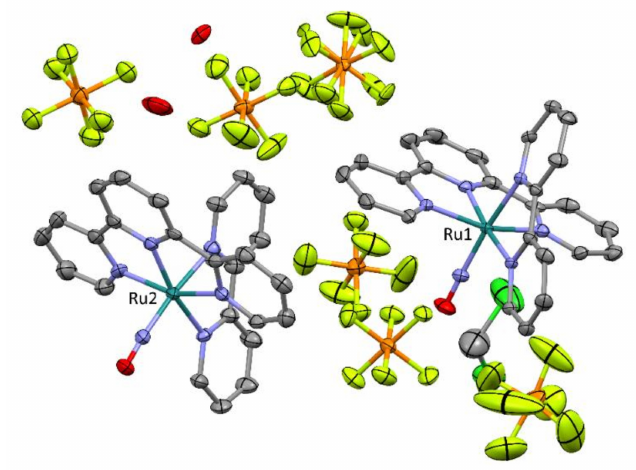
CH 2 Cl 2 –H 2 O. Displacement ellipsoids are 2